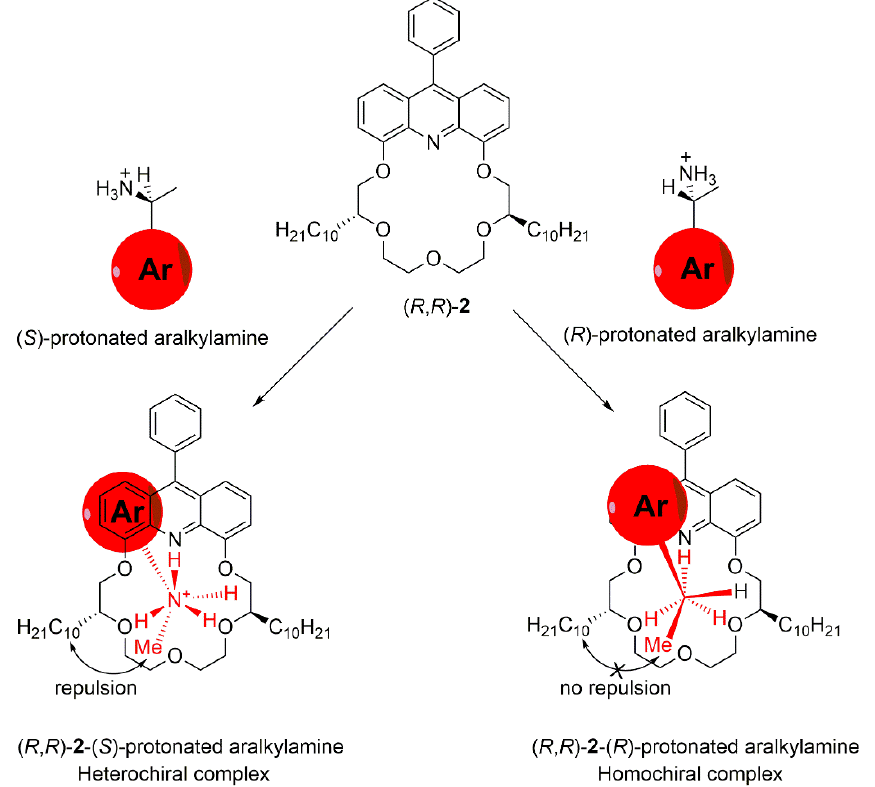
Figure 4. Steric repulsion causing the expected homochiral preference of the enantiopure crown ether ( R , R )- 2 to aralkylamine complexation as an example.